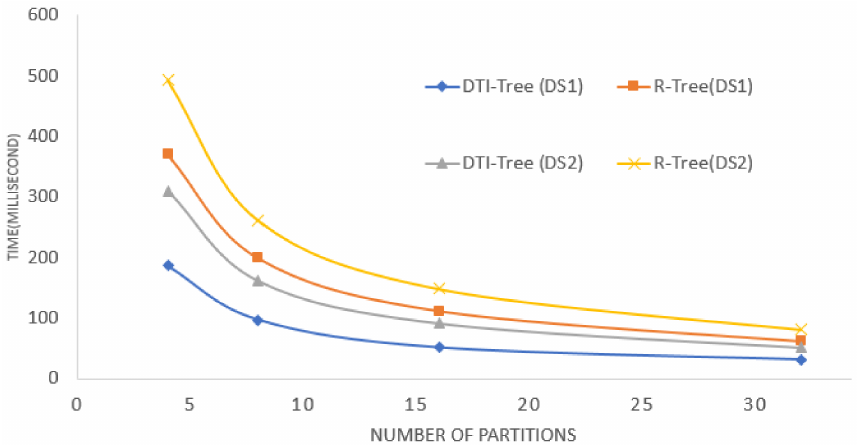
Figure 17. Similarity query performance